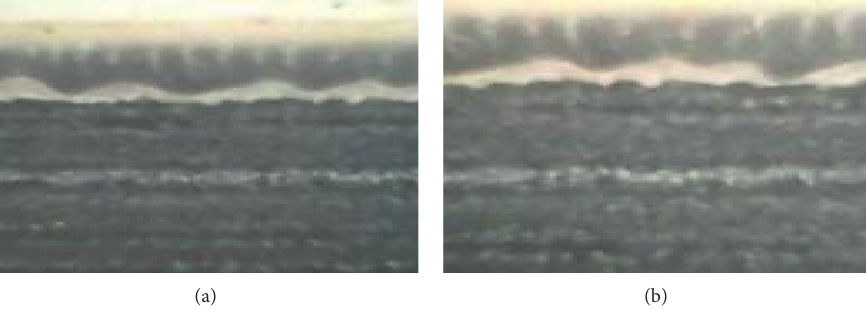
Figure 14: X-ray image of molten aluminum alloy. (a) Honeycomb network. (b) Traditional The frequency spectrum efficiency of the seven-bar honeycomb structure with a diameter of 630 mm is shown in Figure 15. The experimental results show that the area frequency spectrum efficiency of the new vibration network is closely related to the unit fractal. The frequency spectrum efficiency of the cellular network is (54.61%, 78.49%) and stable. The frequency spectrum efficiency of the traditional structural network is (3.74%, 94.74%). The efficiency decreases sharply when the distance from the center of horn is greater than